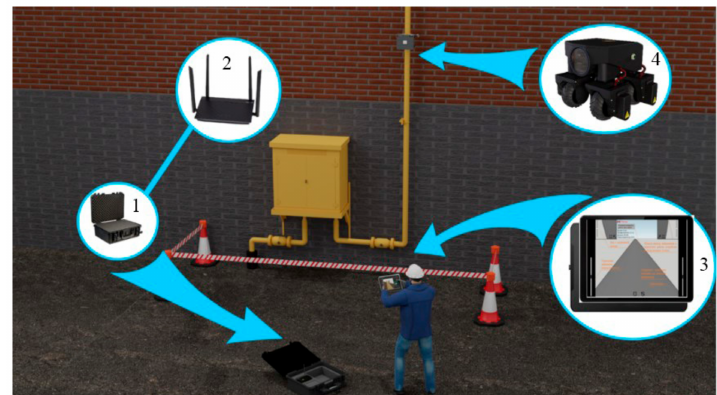
Figure 15. Organization plan for robotic survey. 1—transport case, 2—industrial Wi-Fi router, 3—operator’s tablet, 4—robotic device for pipeline